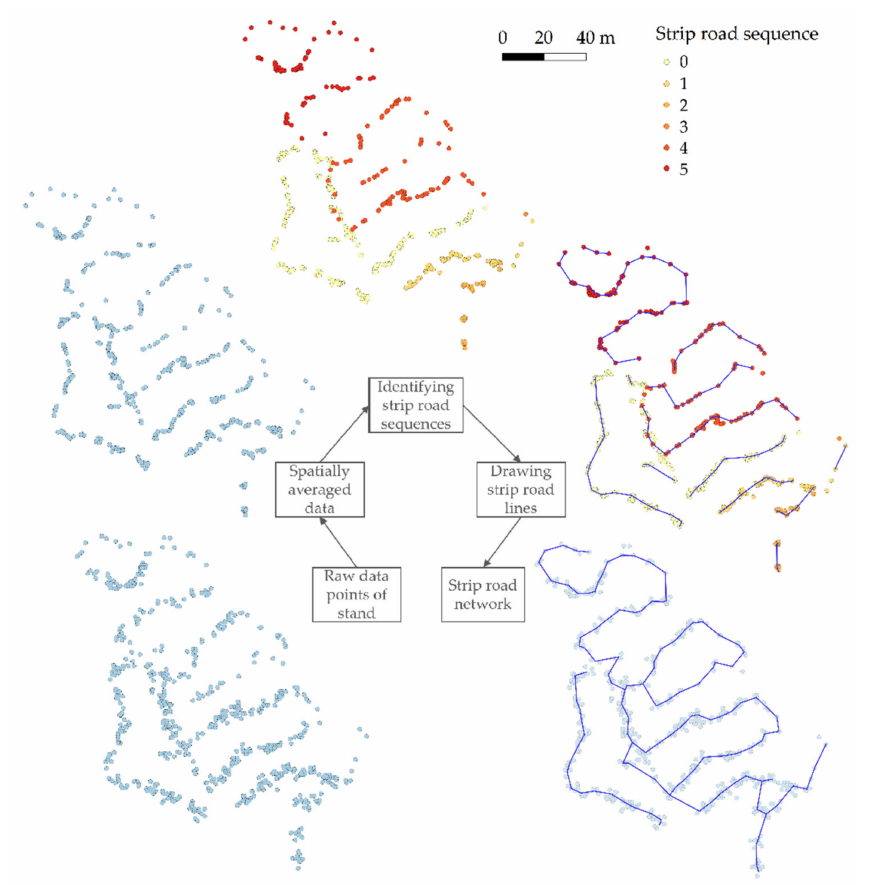
Figure 4. The input data and four phases of computing the strip road network. Note that in the last figure, the raw datapoints are shown in the background of the network for easier comparison between the raw data and the